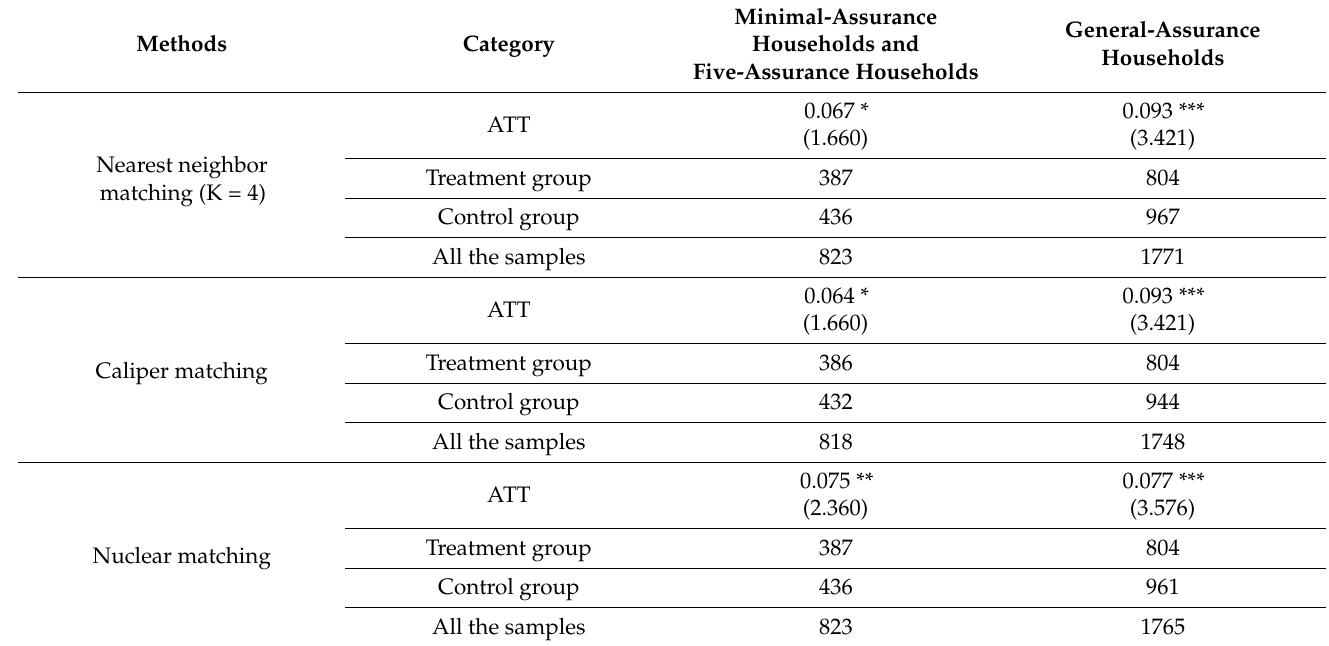
Table 10. Attribute heterogeneity of